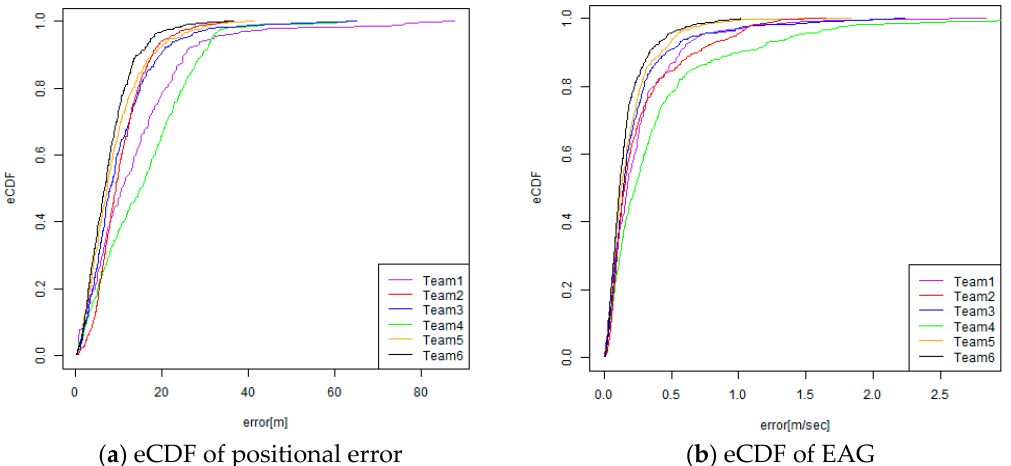
Figure 9. Empirical cumulative distribution function (eCDF) for positional error and error accumulation gradient (EAG).